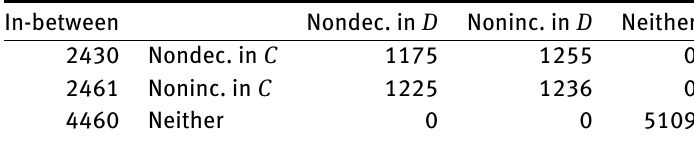
Table 1: Results of 10000 random parameterizations of the causal graph to the left in Figure